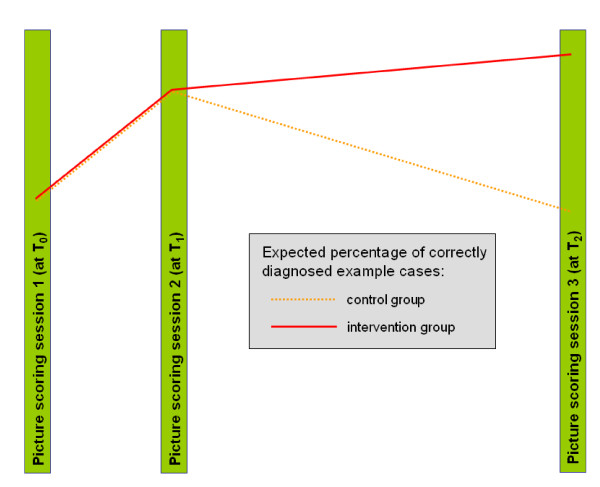
Expected results.